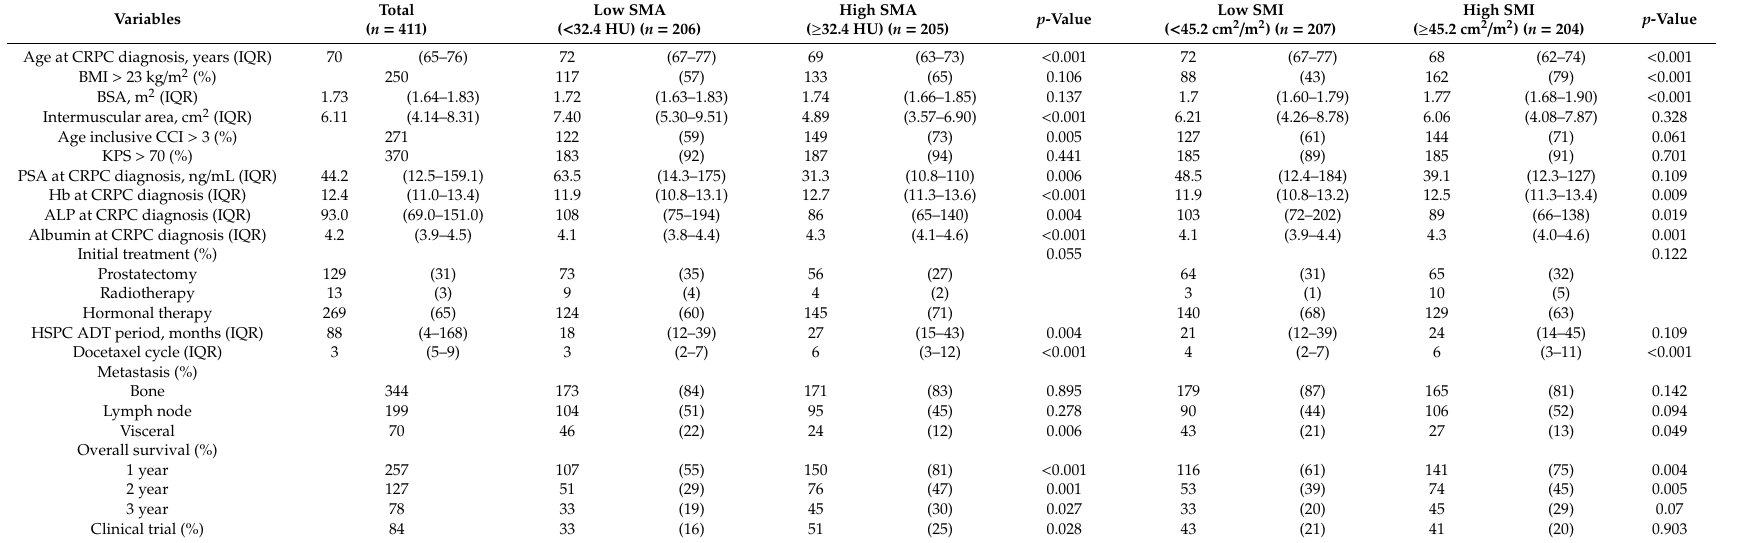
Table 1. Clinicopathological characteristics of patients with castration-resistant prostate